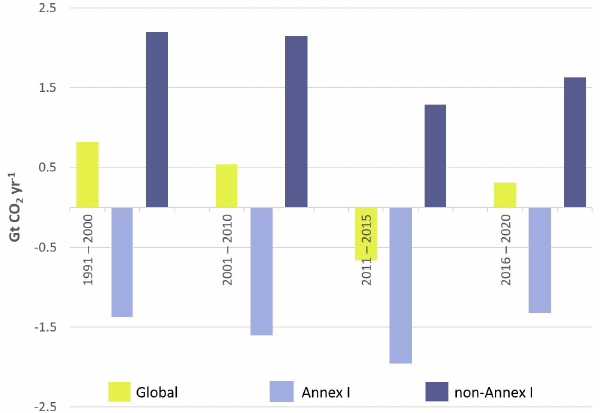
Figure 4. Estimates of total emissions/removals from forests (ER), based on FRA 2020, for global (acid green), Annex I (lavender) and non-Annex I (purple navy) totals in GtCO 2 yr − 1 . Table 2. Estimates of emissions/removals on forest land for Annex I countries, based on FRA 2020 and FRA 2015, compared to country data reported to the UNFCCC (GtCO 2 yr − 1 ).